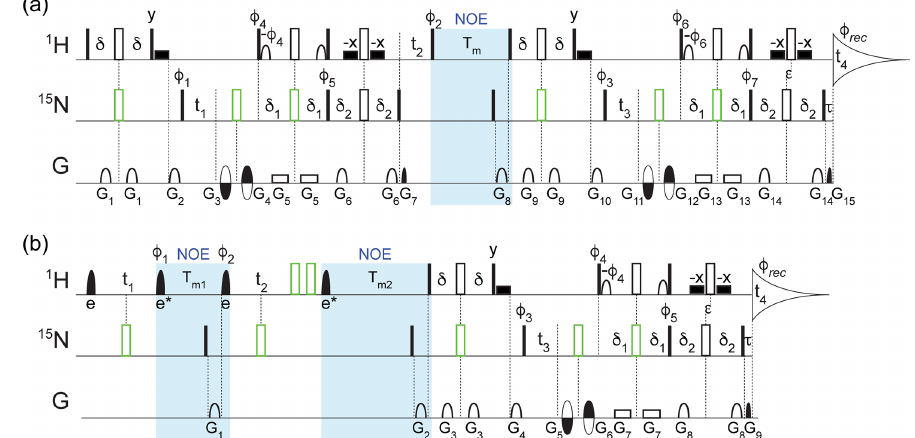
Figure 1. Pulse schemes for four-dimensional (a) TROSY-NOESY-TROSY and (b) NOESY-NOESY-TROSY experiments. The filled and open rectangular bars on the 1 H and 15 N channels represent 90 and 180 ◦ pulses, respectively. The open bars in green represent composite 180 ◦ pulses consisting of 90 ◦ x 207 ◦ y 90 ◦ x for 1 H and 90 ◦ x 216 ◦ y 90 ◦ x for 15 N. The filled shaped 1 H pulses correspond to selective EBURP2 (labeled e) and time-reversed EBURP2 (labeled e*) pulses (Geen and Freeman, 1991), while the open 1 H-shaped pulses represent 90 ◦ water-flipback pulses (center lobe of a sinc profile, 1.1ms duration at 800MHz) (Grzesiek and Bax, 1993). The wide filled rectangular boxes denote 90 ◦ water-flipback pulses (also 1.1ms duration at 800MHz). Unless indicated otherwise, all pulses were applied along